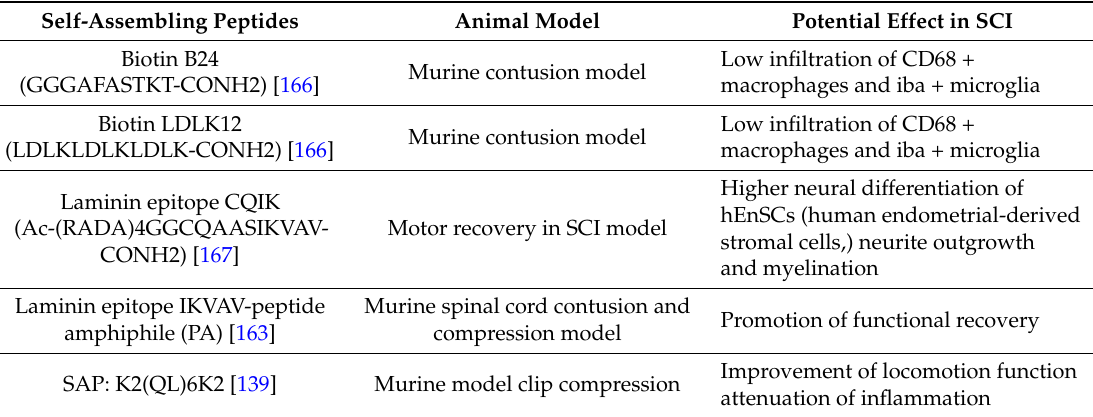
Table 7. Self-assembling peptides reported in the literature for treatment of